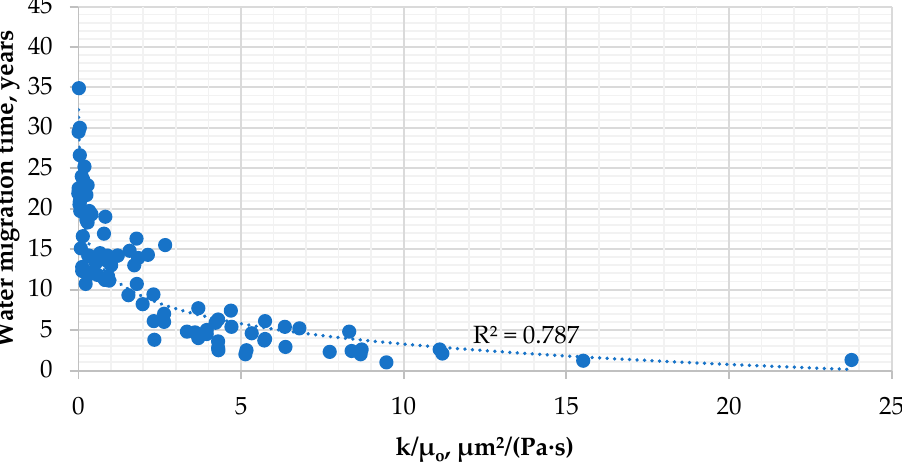
Figure 7. Dependence of the water migration time on the mobility factor.